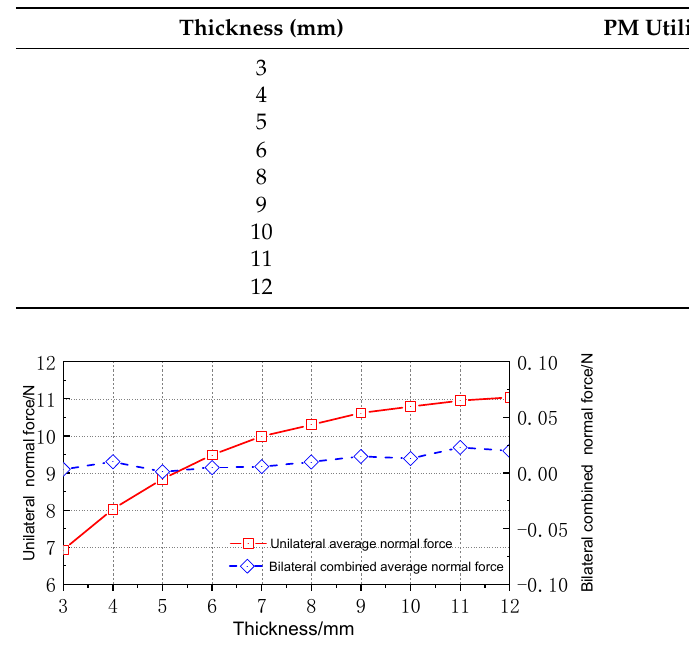
Table 4. PM utilization ratio of different magnet thicknesses.